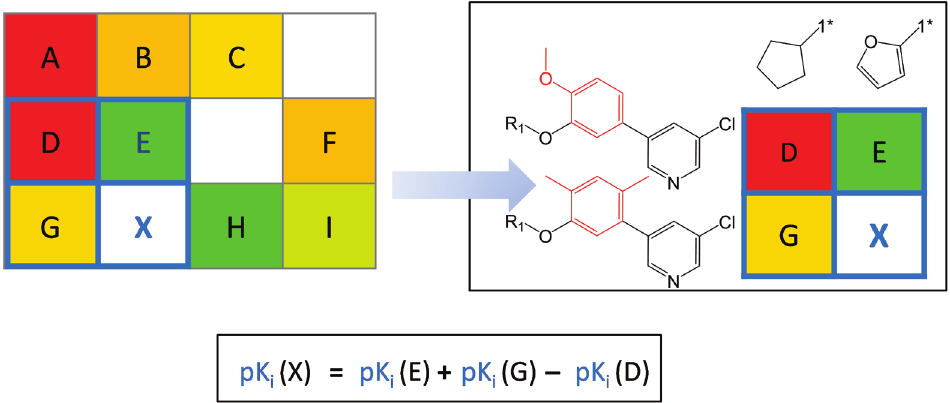
Figure 5. Neighborhood-based potency prediction. An NBH of virtual compound X is marked in blue in a model SARM and displayed in detail. Compounds E and G share the same substituents and core with X, respectively, and the third neighbor D combines the core and substituent of E and G, respectively. At the bottom, the equation to predict the potency of X from the potency values of E, G, and D is shown.